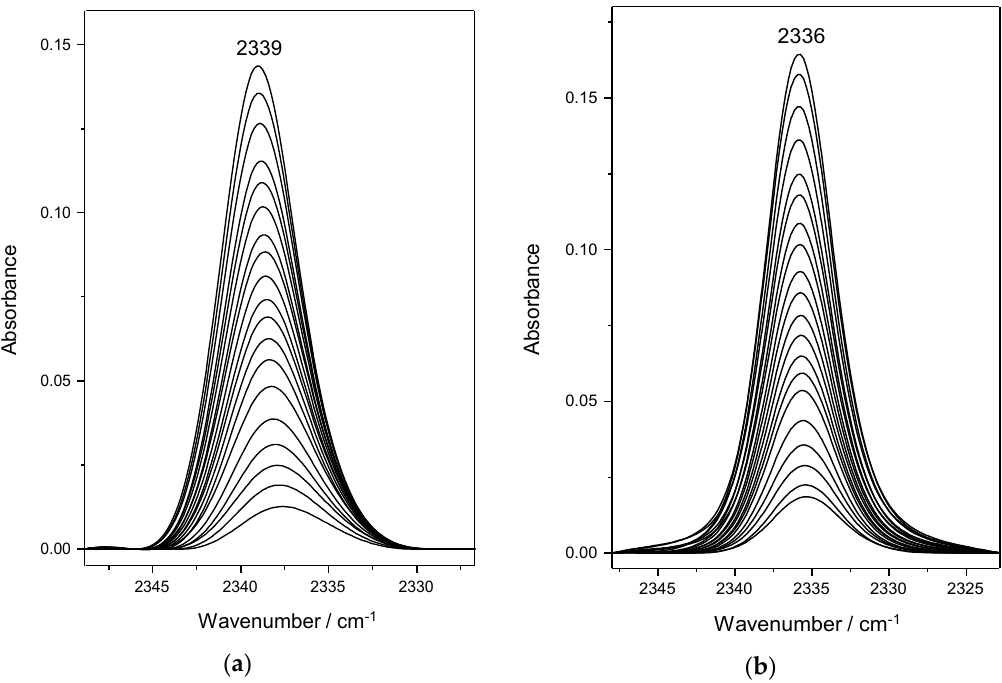
Figure 3. ( a ) Representative variable-temperature IR spectra of N 2 adsorbed in Ca-Y. From top to bottom temperature increases from 207 to 266 K; and equilibrium pressure from 1.05 to 1.77 mbar. ( b ) Representative variable-temperature IR spectra of N 2 adsorbed in Sr-Y. From top to bottom temperature increases from 191 to 239 K; and equilibrium pressure from 2.27 to 3.28 mbar.